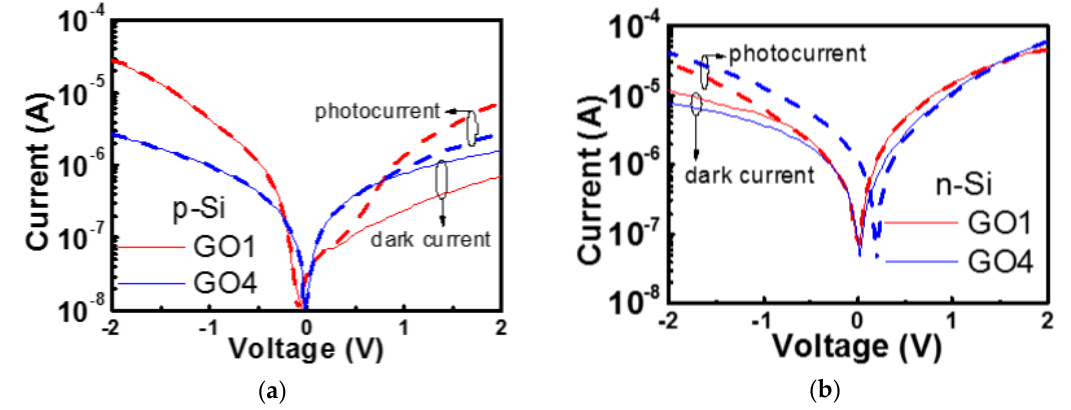
Figure 5. Dark currents and photocurrents of GO1 and GO4 heterojunction photodetectors on ( a ) p-Si and ( b ) n-Si. The photocurrents were measured under white light from white light emitting diodes with a power density of 0.5 mW/cm 2 .